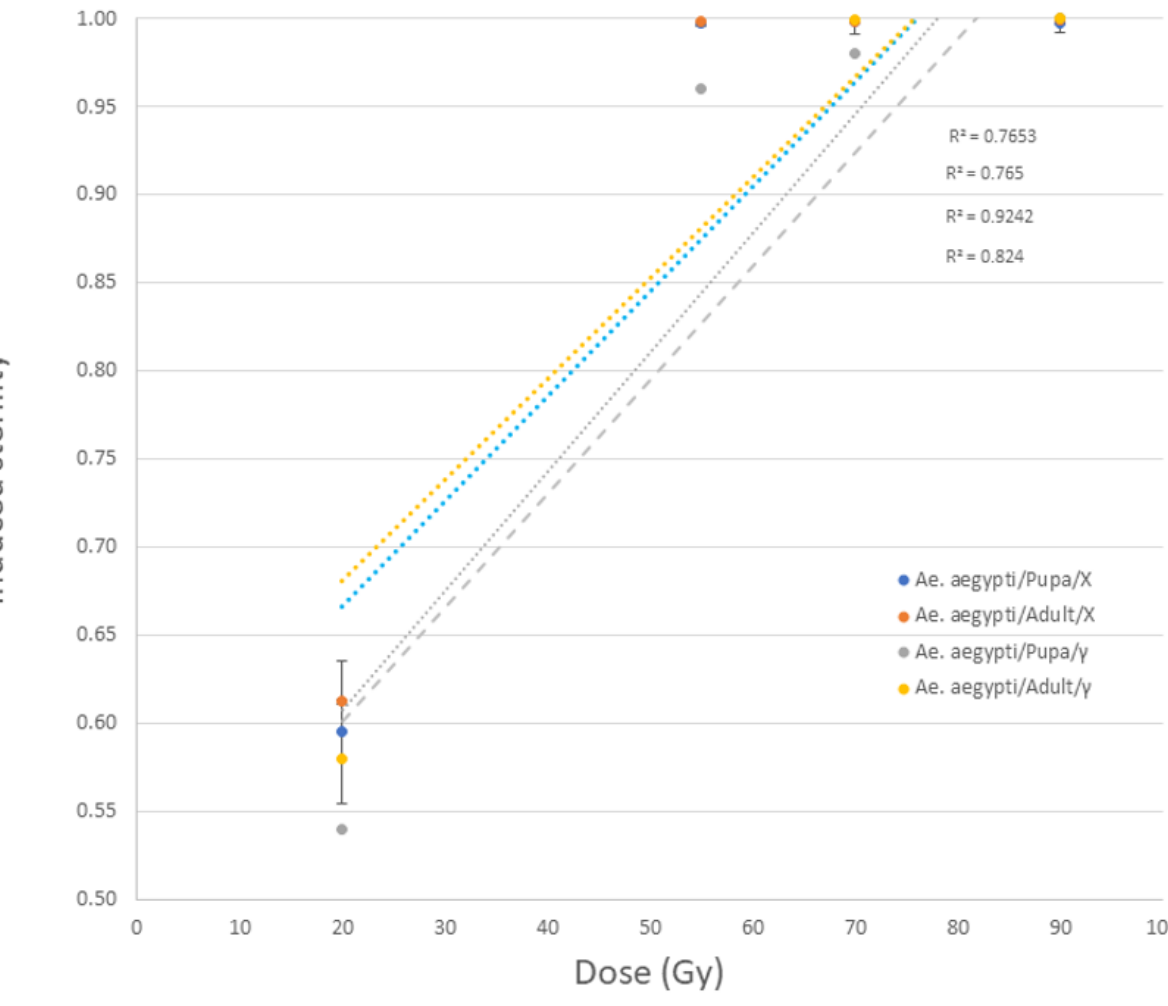
Figure 4. Dose response data of Ae. aegypti male pupae and adults irradiated with MK2 (X-ray) irradiator compared to the same strain irradiated in a GC220 instrument (gamma ray, (Yamada et al., 2022)).